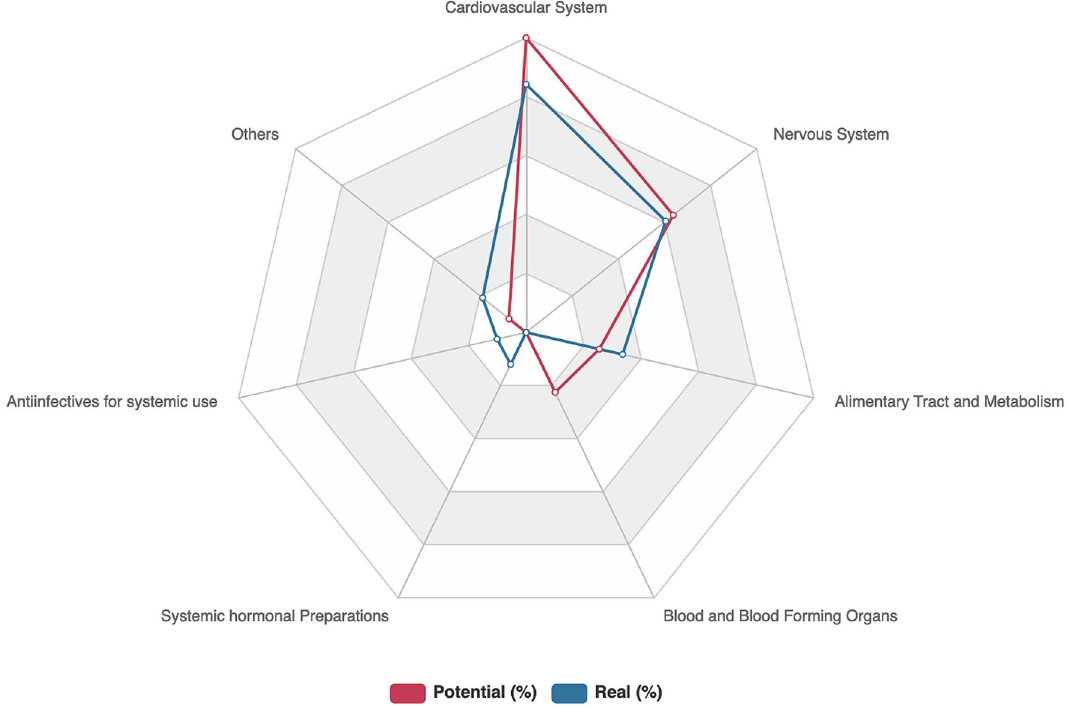
Figure 1. DDIs between experimental COVID-19 therapies and comedication according to ATC classification first